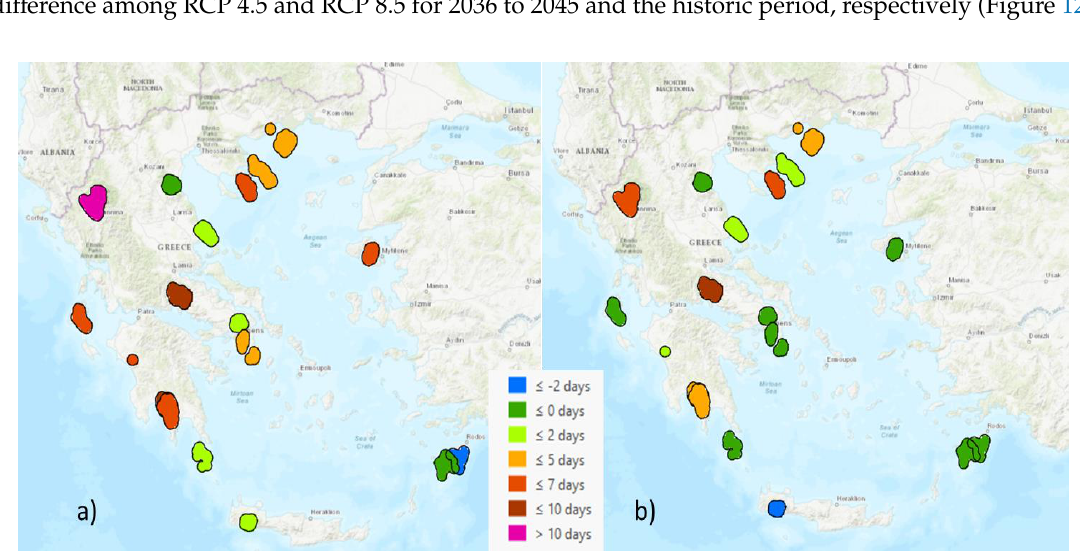
Figure 12. Differences in the results of maximum number of days with extreme Fire Weather Index (range depicted with colours) within the areas of interest between: ( a ) RCP 4.5 and historic data sets, ( b ) RCP 8.5 and historic datasets.